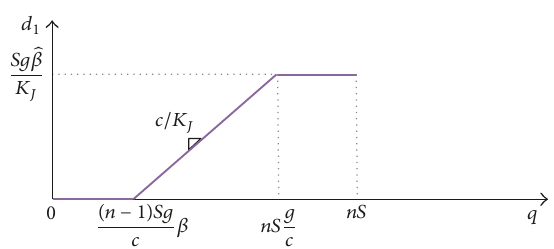
Figure 3: Value of 𝑑 1 in relation to the traffic demand volume 𝑞